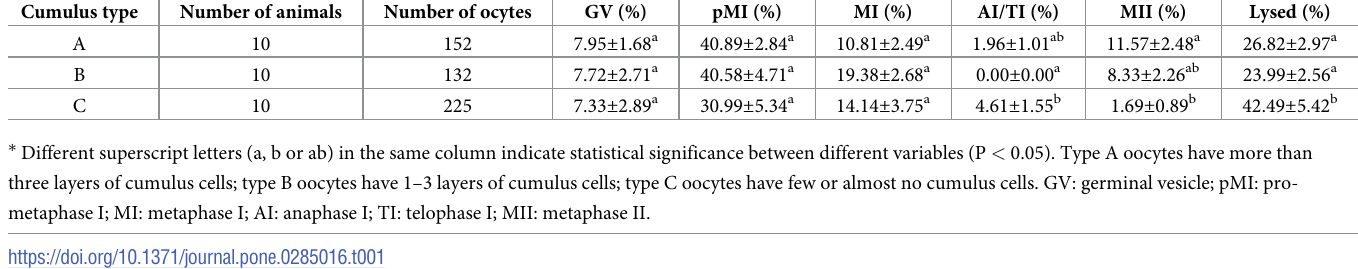
mL) + LH (5 IU/mL) + L-Cys ((200 μ M) + Cys (100 μ M) + IBMX (50 μ M), or hCG (1 IU/mL) Table 1. Effects of different cumulus cell types (layers) on in vitro maturation of oocytes collected from natural cycling guinea pigs. Cumulus type Number of animals Number of ocytes